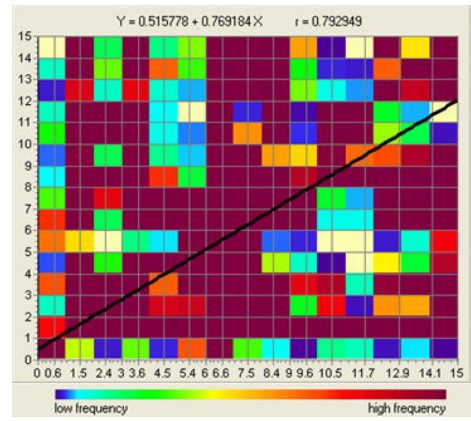
Figure 11. Spatial relationship between predicted LULC of 2007 (using 5x5 contiguity filter) and LULC derived from LISS III image of 2007 (references